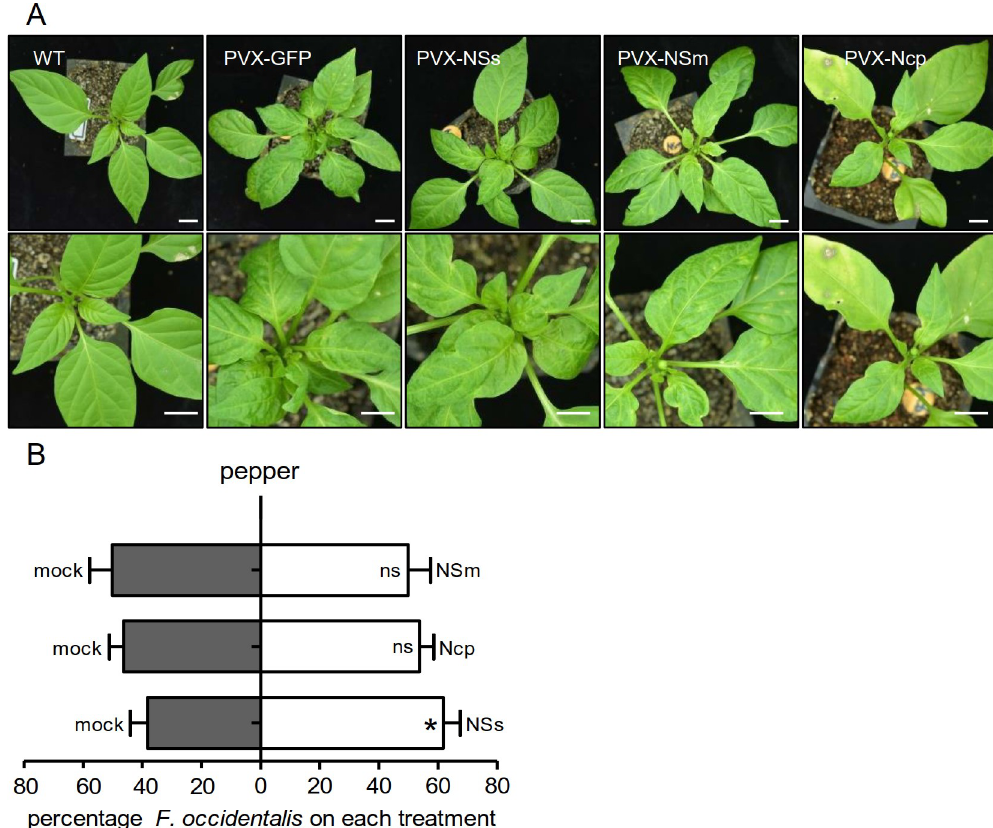
Fig 3. NSs from TSWV is a vector behavior manipulator. (A) Phenotype of pepper leaves inoculated with recombinant Potato virus X (PVX) vectors. PVX-NSs, PVX-NSm or PVX-Ncp was transformed into peppers via agroinfiltration. PVX-GFP was used as the control. Bar = 2 cm. (B) Attractiveness of different infiltrated peppers. Agrobacteria carrying individual recombinant PVX vectors were infiltrated into peppers. Plants of a similar size were used for thrips two-choice assays at 10 dpi. Data are mean choice percentages + SE, n = 6. � P < 0.05, Wilcoxon matched pairs